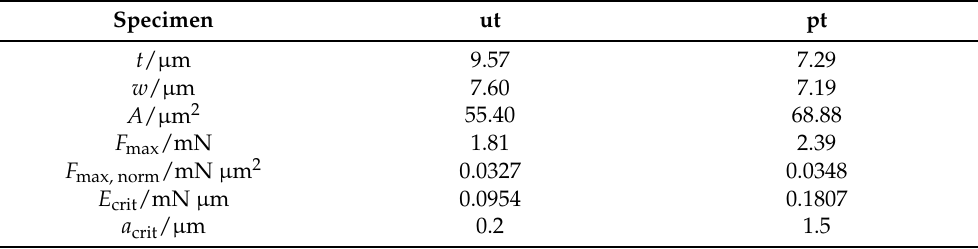
Table 3. Dimensions an test results for the bending beams of the untreated (ut) and pre-treated (pt) specimen: beam thickness t , beam width w , cross-sectional area A , maximum force F max , maximum force normalized F max, norm , critical energy E crit , critical crack length a crit .